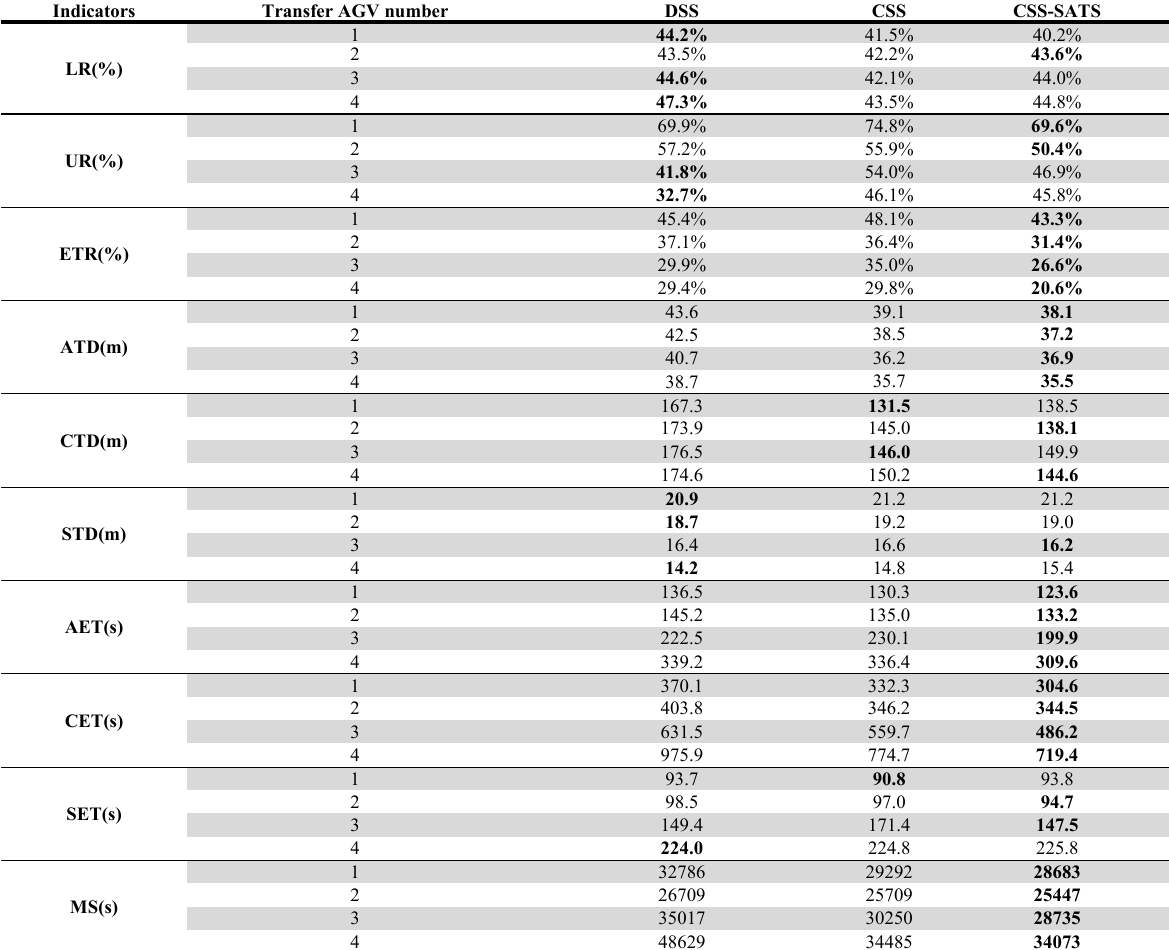
Result s of experiment A (The bold is the best value among three algorithms) Indicators